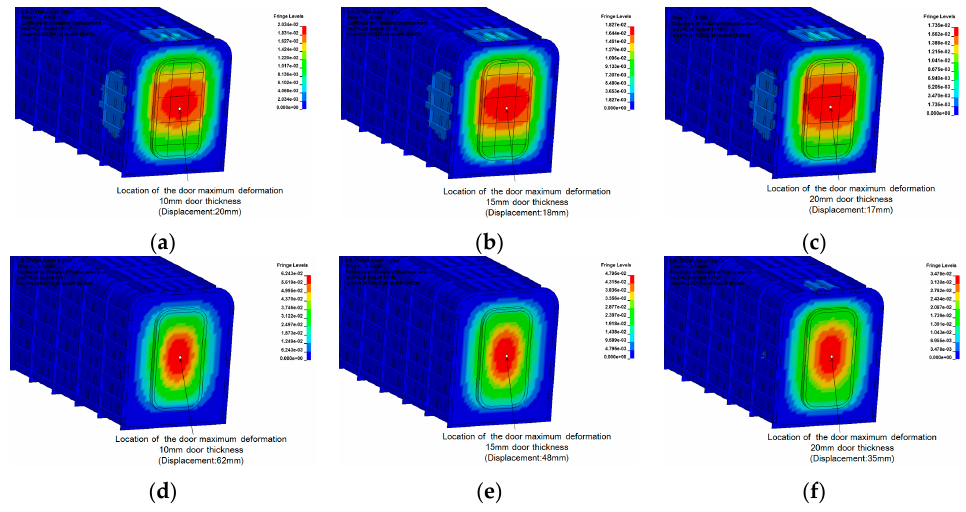
Figure 6. Maximum displacement ‐ time curves with different front door thicknesses. ( a ) Door with stiffeners and ( b ) door with no stiffeners.